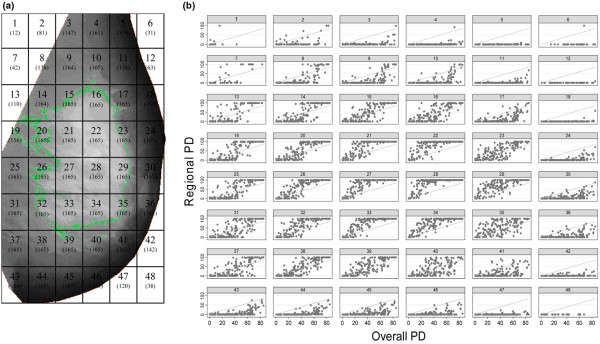
Plots of regional versus overall percent density for all study participants. (a) Schematic representation of the defined 48 regions in the breast (numbers in brackets indicate number of women who had breast tissue in the relevant region at the left exit medio-lateral oblique (MLO) screen). (b) Regional percent density (PD) plotted against overall PD (at the left exit MLO mammograms), by region.